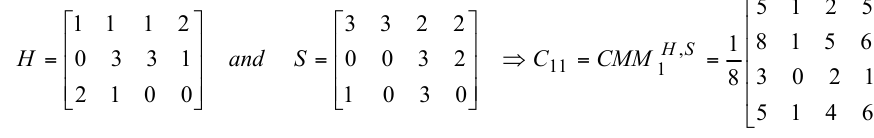
Figure 5. Example of calculating mean CMM.